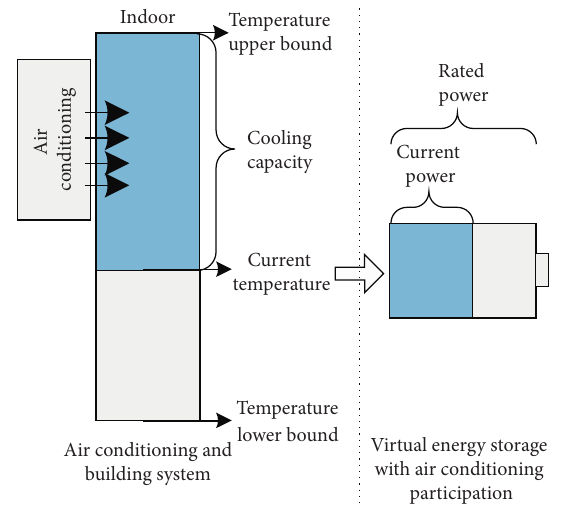
Figure 1: Schematic diagram for virtual energy storage with air conditioning participation.